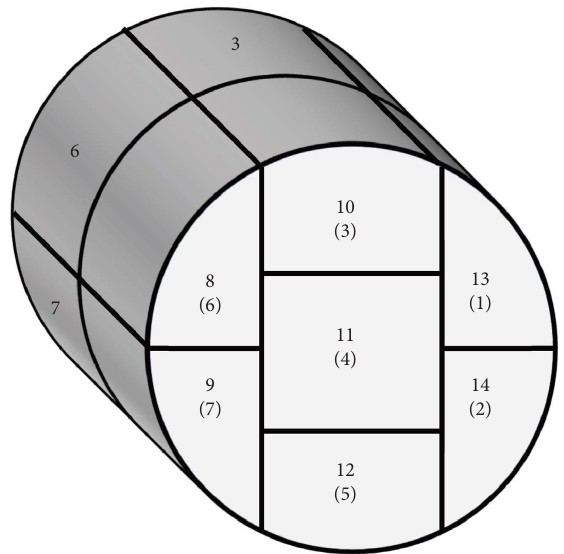
Figure 1: Liquid zone number designation for CANDU